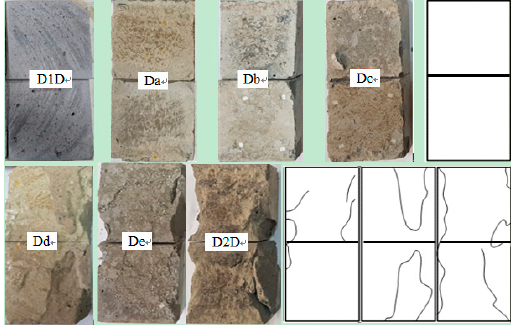
Figure 13. Failure characteristics of the samples.